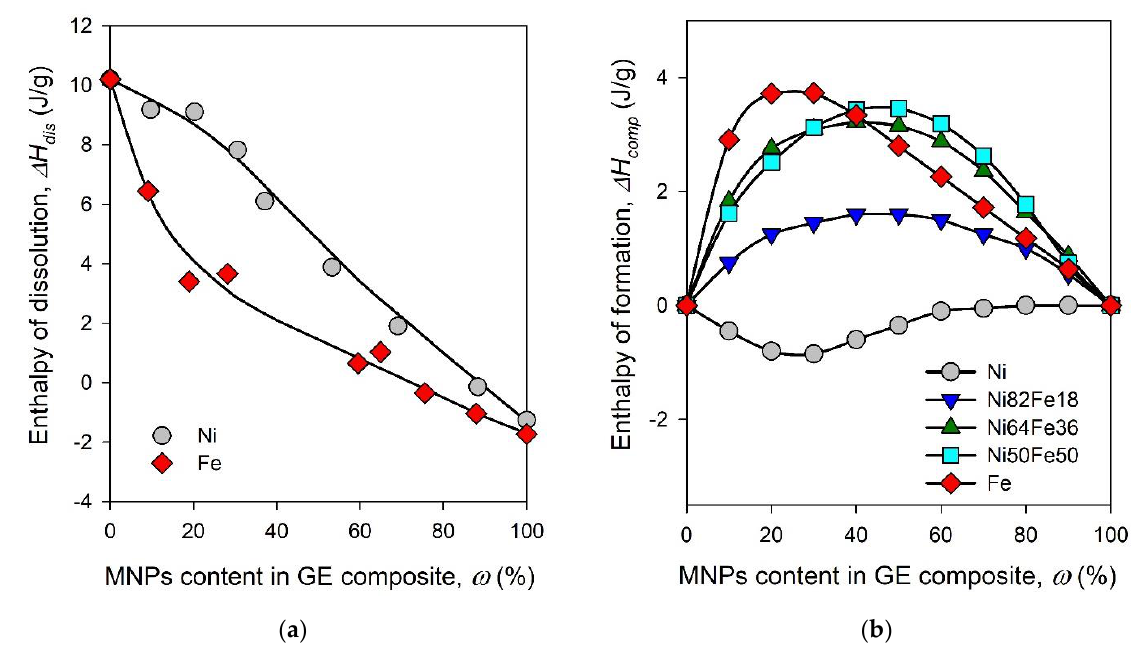
Figure 3. Concentration dependence of the enthalpy of dissolution in isopropanol for GE composites with Ni and Fe MNPs ( a ). Concentration dependences of the enthalpy of formation for GE/MNPs composites ( b ). T = 25 °C.